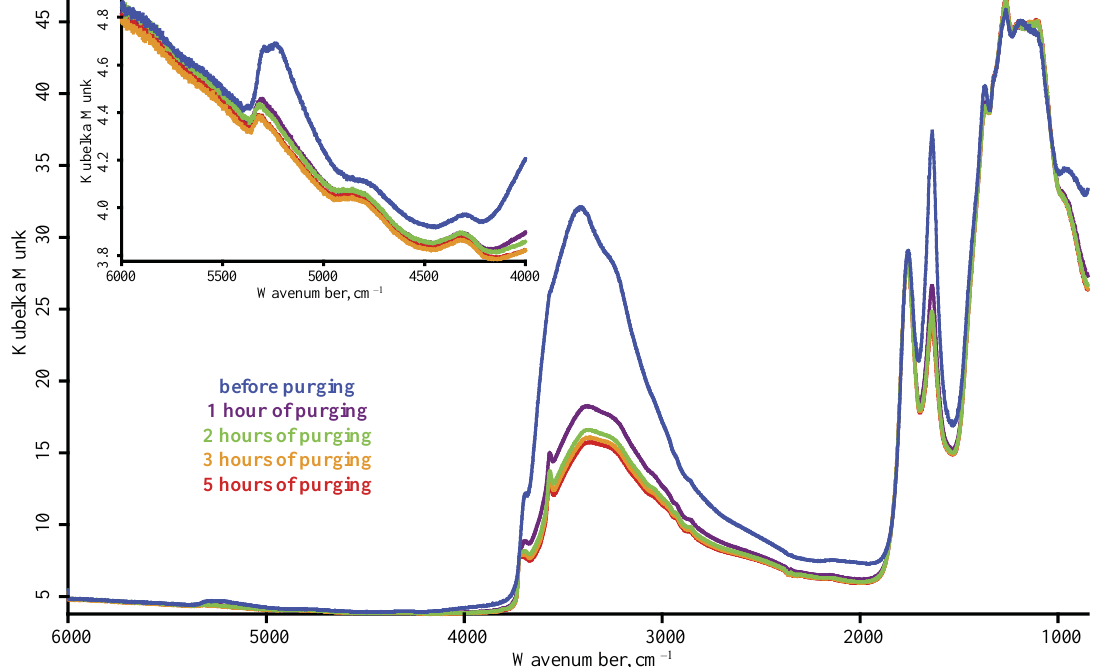
Figure A3. RUDDM nanodiamonds, DRIFT with MCT; blue, immediately when the sample was placed into accessory; purple, after 1 h of purging sample inside accessory; green, 2 h; orange, 3 h; red, 5 h. Spectra were not smoothed and normalized.